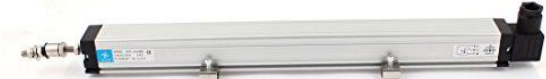
Figure 6. Linear potentiometer model: Uxcell BWL300MM.